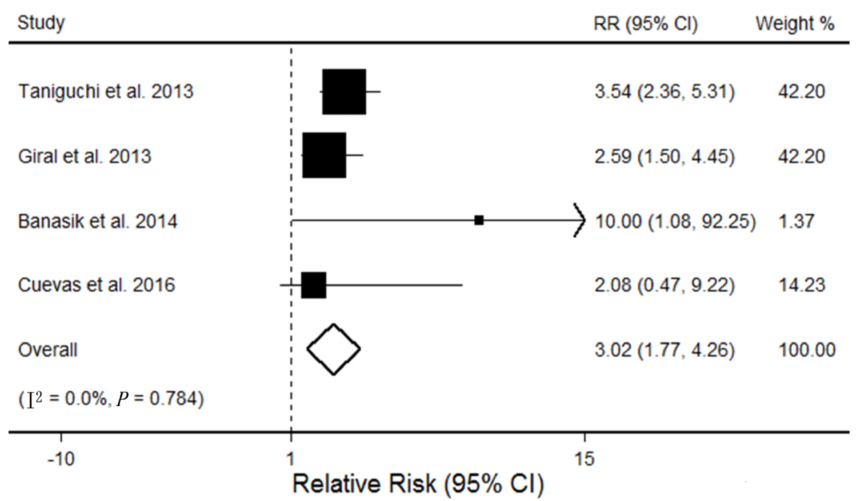
Figure 4. Forest plot on the association between AT1R-Abs and kidney graft failure. For each study, the estimation of RR and its 95% CI are plotted with a box and a horizontal line. The pooled odds ratio is represented by a diamond. The area of the gray squares reflects the weight of the study in the